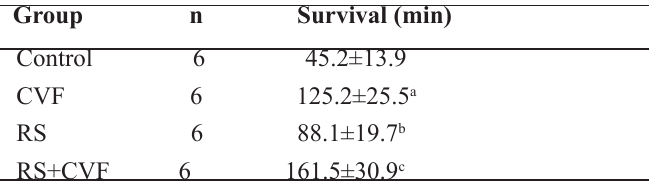
xenotransplantation and subsequent different treatments ( x ± S